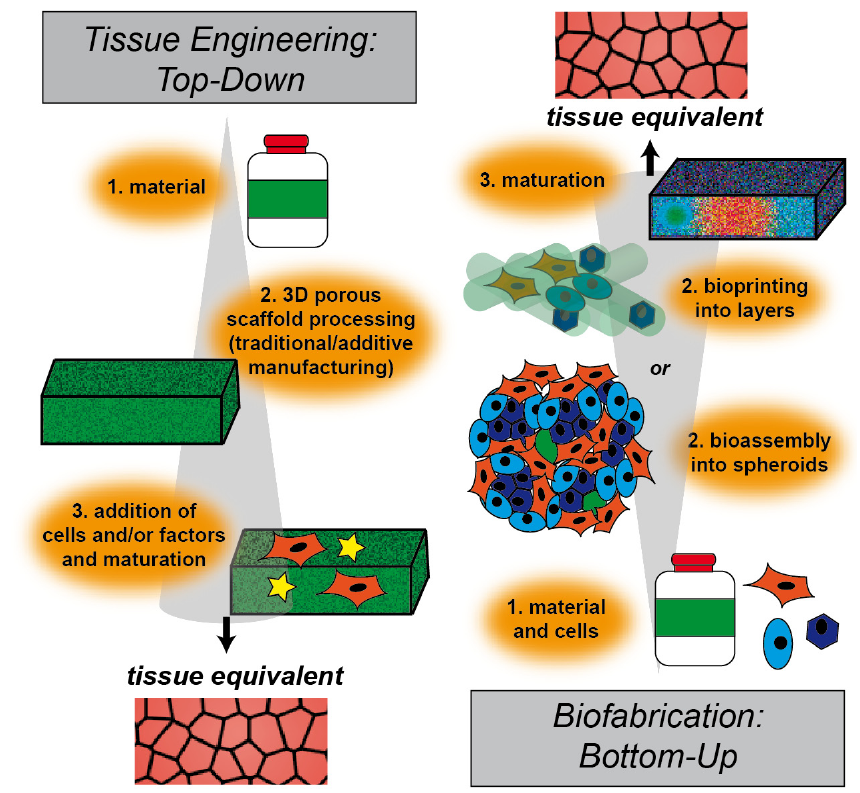
Figure 1. Schematic illustration of engineering approaches to fabricate tissue. In top-down strategies, a scaffold is produced, followed by cell seeding and/or addition of factors for cellular stimulation. This technique is called tissue engineering. Bottom-up approaches use cells and raw materials simultaneously to build larger constructs, which are then maturated. This technique is called biofabrication.